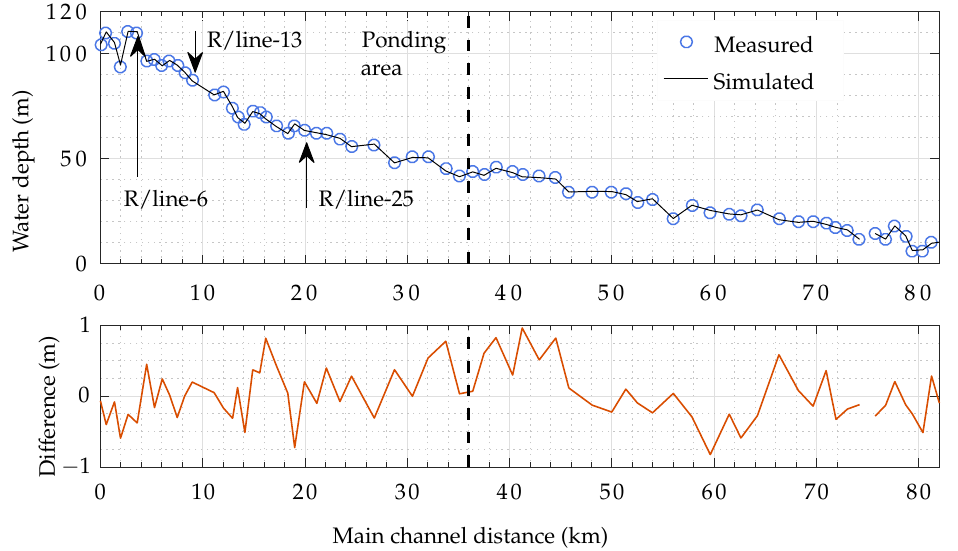
Figure 9. Comparison of mean measured and computed water depths at each cross section.